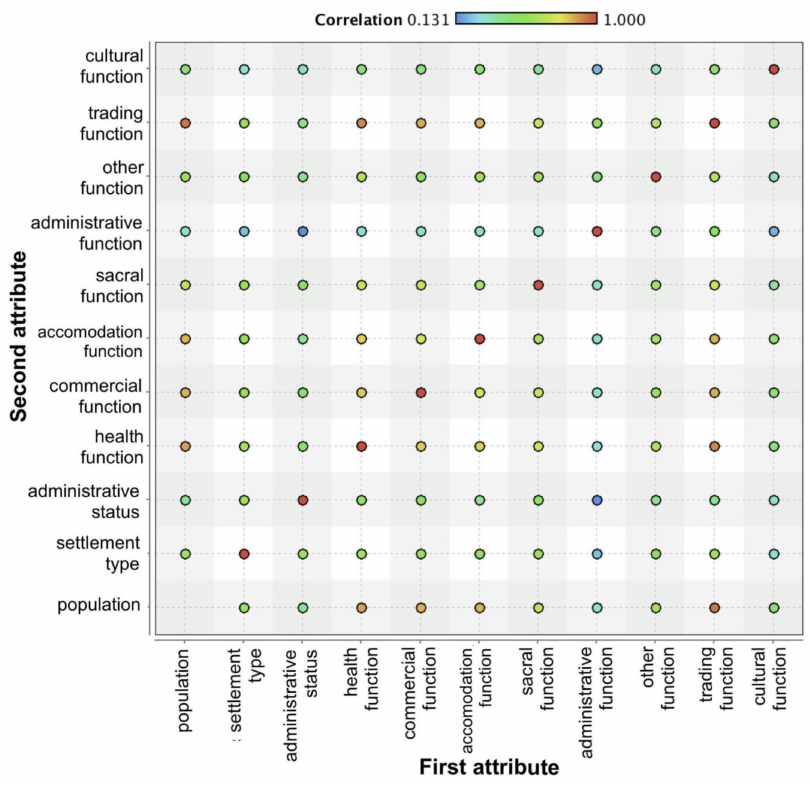
Figure 11. Variables’ correlation strength. Calculated for all four district